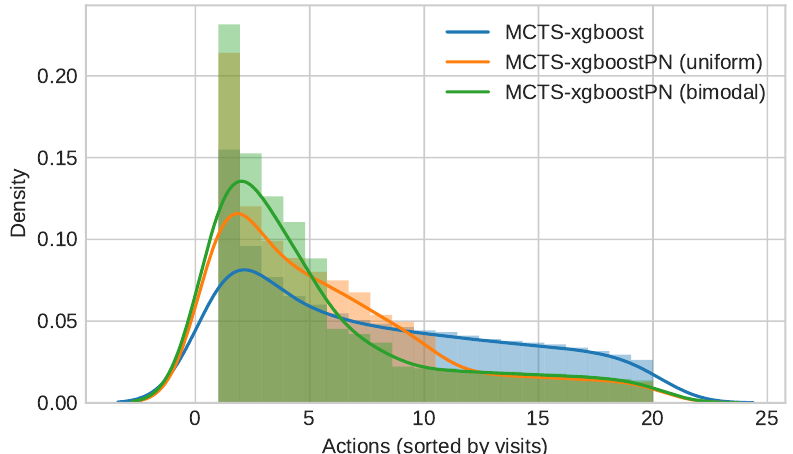
Figure 4. Actions’ visits distributions with and without pruning networks (500